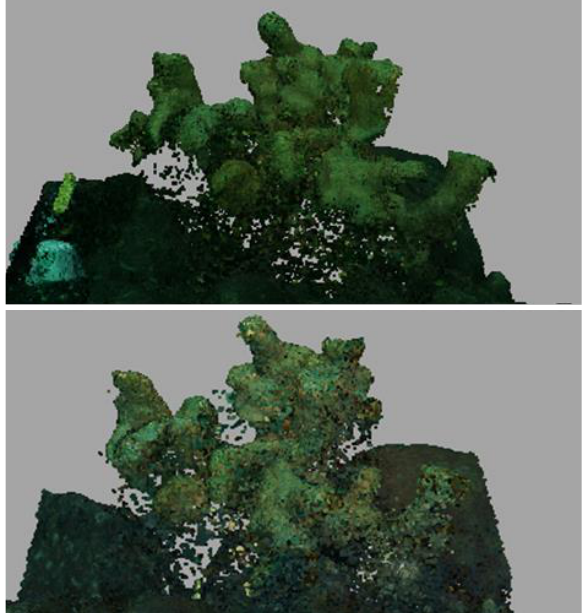
Figure 6. Survey 2 evaluated SfM data quality resulting from handheld underwater photography. (Top) Survey 2A – Single wide beam dive light (800 lumens). (Bottom) Survey 2B – single extra-wide beam dive light (1200 lumens). Both models contained a significant number of